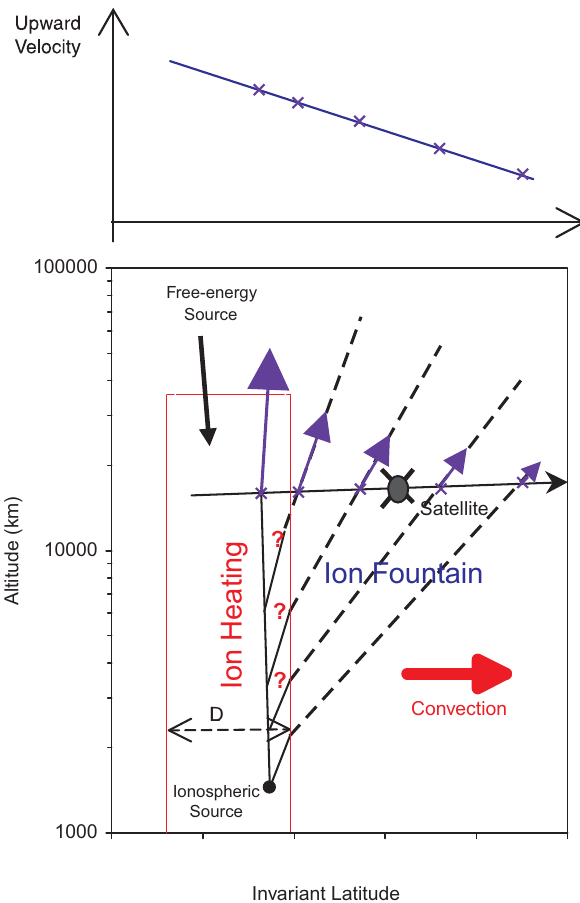
Fig. 1. Sketch illustrating the transport patterns of ion outflows from the cusp/cleft in conjunction with a satellite crossing. The trajecto- ries are projected in a meridian plane and are functions of invariant latitude and